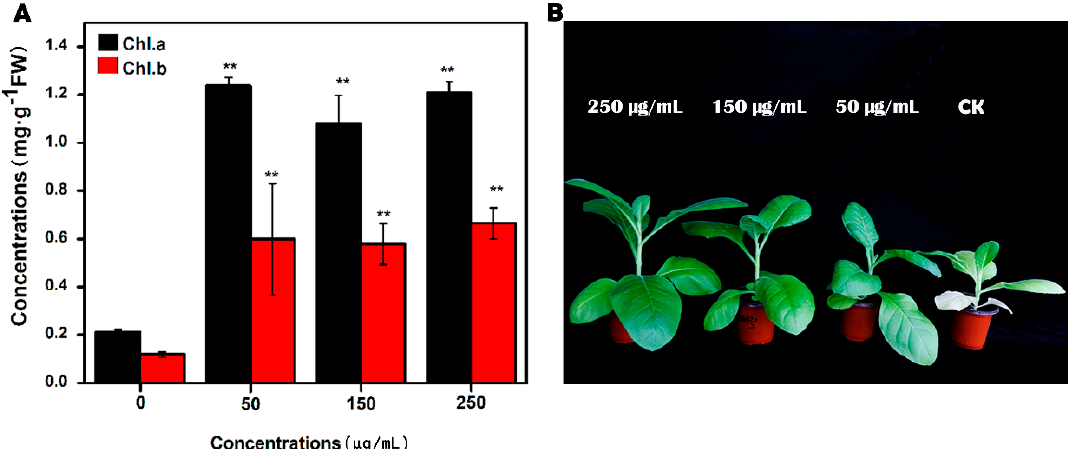
Figure 2. Effect of the different concentrations of MgONPs on the chlorophyll analysis of the tobacco plant, ( A ) chlorophyll concentrations, and ( B ) the phenotype of tobacco plants with MgONPs of 250, 150, 50 and 0 µ g/mL from the left to right. Error bars represent the standard deviation, ** p < 0.01.